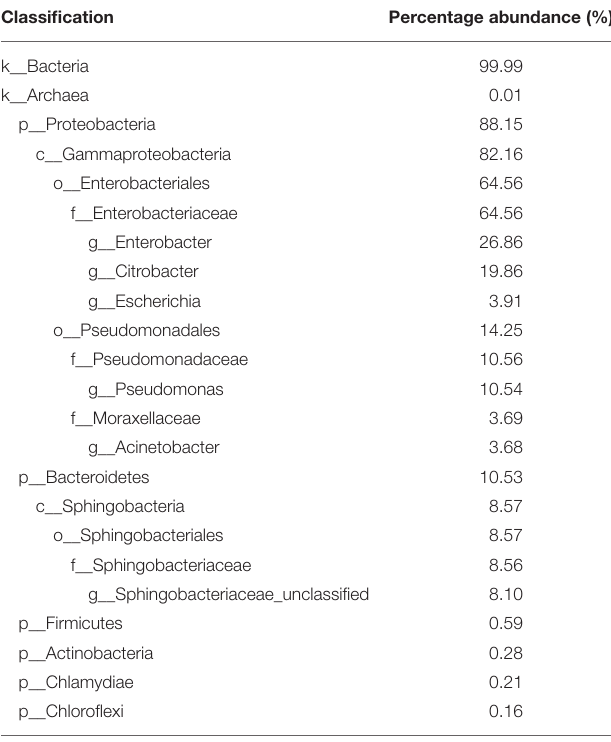
TABLE 3 | Microbiome abundance of plant pathogens present in the A. ater gut microbiome, as ranked by a survey of experts carried out by Mansfield et al. (2012)